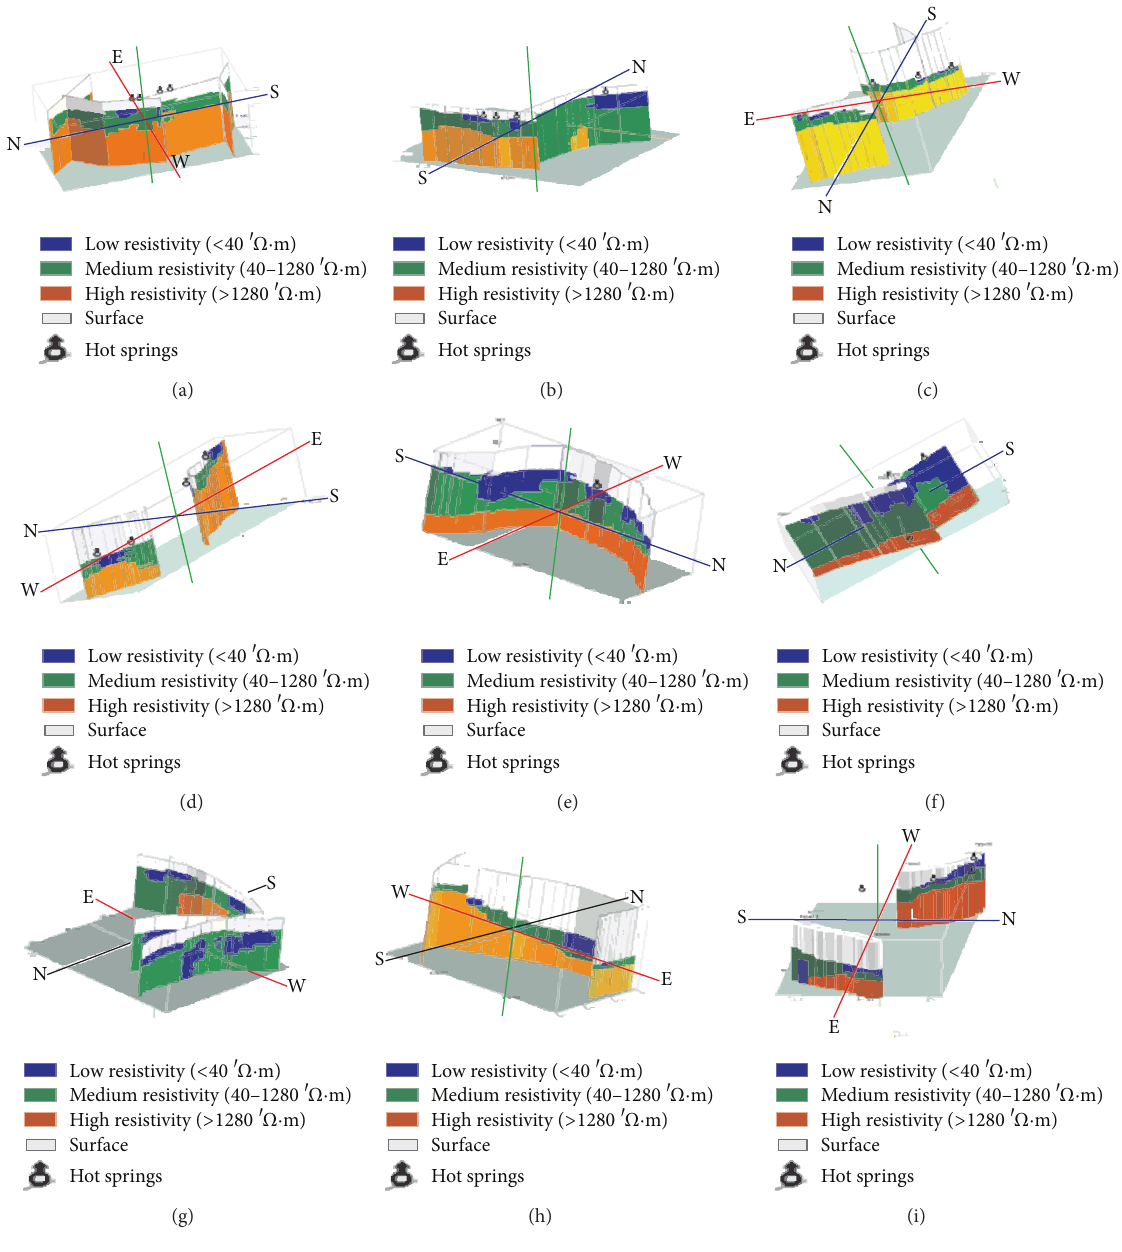
Figure 4: Result of resistivity data processing at 9 measurement locations in Blawan geothermal